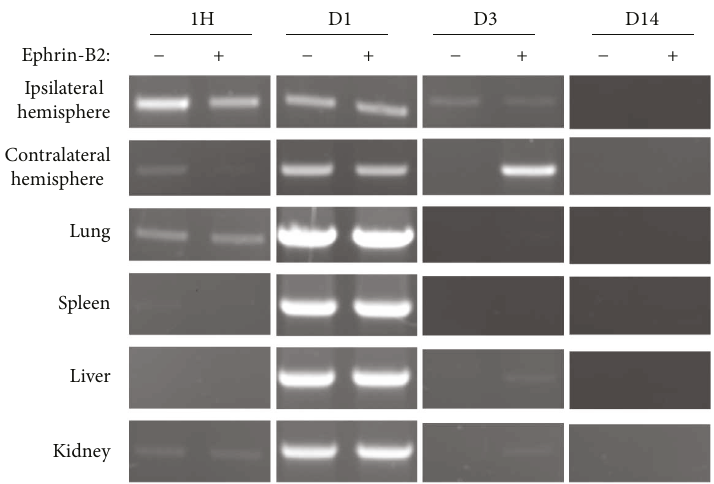
Figure 8: Cell tracking detection of human DNA in mice transplanted with human PB-MNC and PB-MNC+. DNA was extracted from mouse tissues and ampli fi ed using PCR to detect the human-speci fi c P17H8 satellite sequence. Agarose gel analysis of PCR products demonstrated the presence of a 1171-bp human-speci fi c fragment as early as one hour after cell injection mainly in the ipsilateral hemisphere and in the lungs of PB-MNC+ and unstimulated PB-MNC-treated mice. At D1 after injection, human DNA was readily detectable in the lungs, spleen, liver, and kidneys and in the contralateral hemisphere, whereas human DNA was still present in the ipsilateral hemisphere and had increased in the lungs. Signal disappeared from all organs, including brain, by D14 ( N = 5 ).